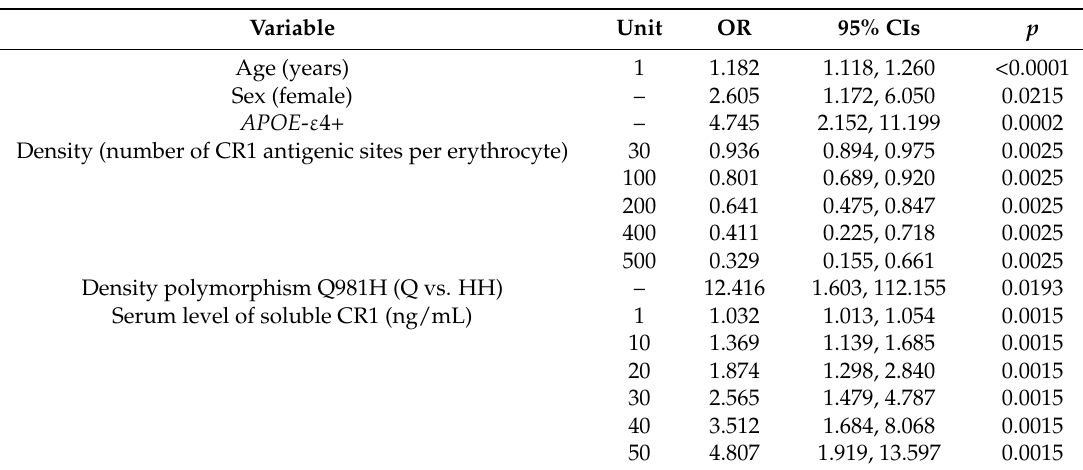
Table 4. Multivariate analysis of factors independently associated with Alzheimer’s disease at different levels of variation in the explanatory